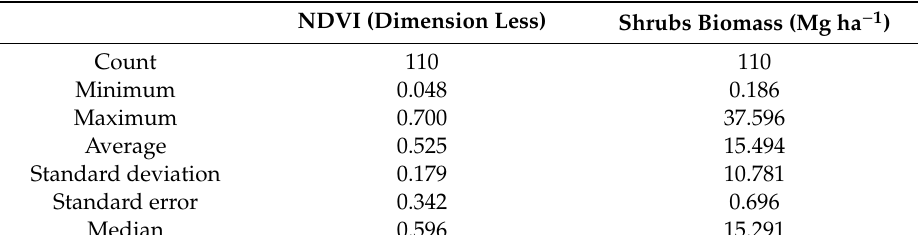
Table 4. Descriptive statistic for the total sample.